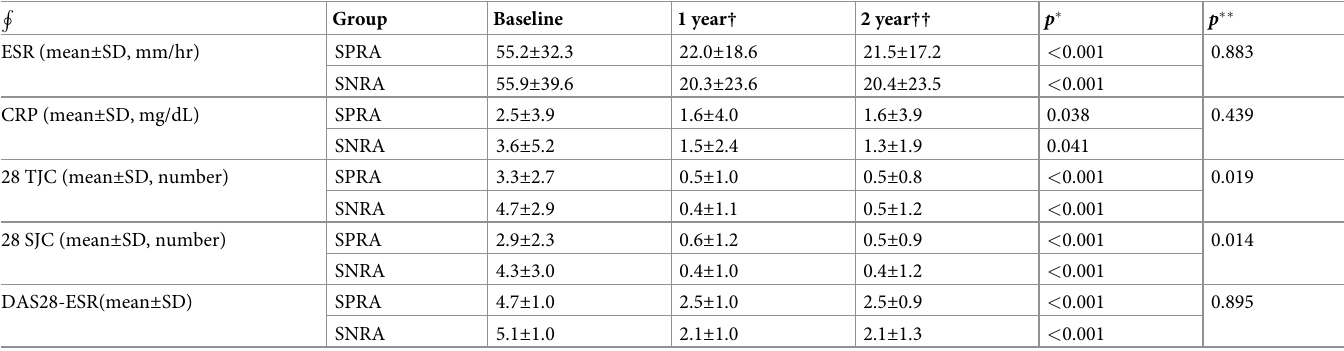
Table 3. Comparisons of treatment outcome.